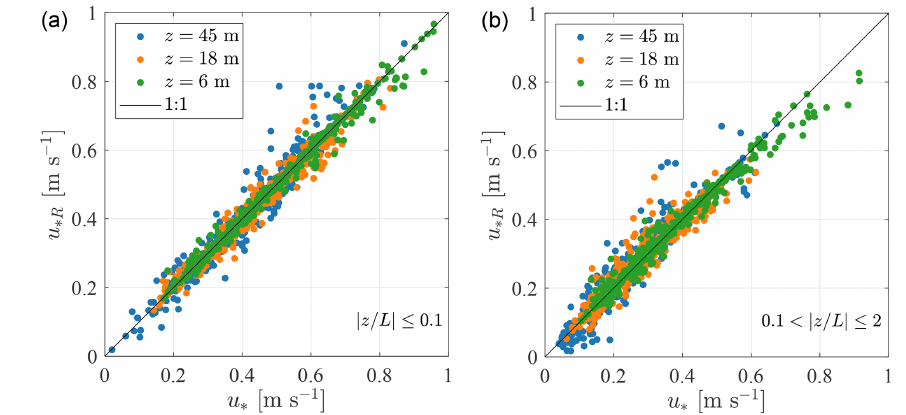
Figure A1. Friction velocity computed using the eddy covariance method with the double-rotation method compared with the Klipp method. Panel (a) considers only | z/L | ≤ 0 . 1, and panel (b) considers 0 . 1 < | z/L | ≤ 2.